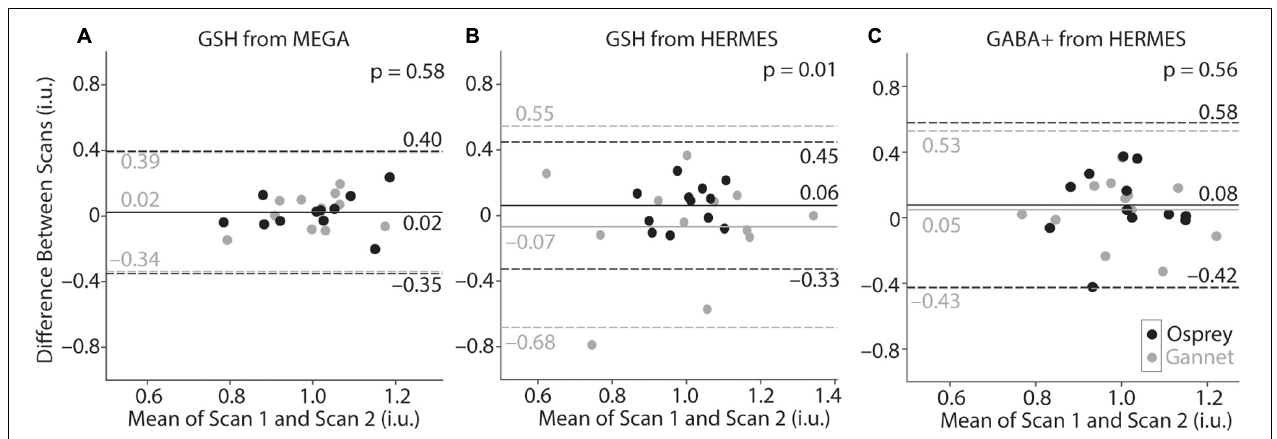
FIGURE 5 | Bland-Altman plots of GSH-edited MEGA-PRESS (A) and GSH-edited (B) and GABA+-edited HERMES (C) data processed by Osprey (black) and Gannet (gray). Values for Gannet and Osprey have been normalized so that the mean of all values is 1, for the purposes of overlay. Solid lines represent the mean of the difference between scans, while dotted lines represent the 95% confidence